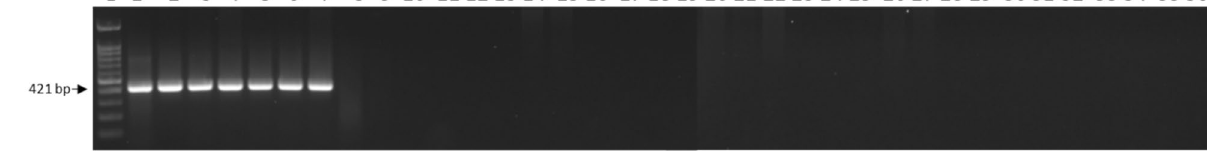
Figure 3. The specificity validation of the endpoint PCR primer pair designed to specifically detect Dickeya fangzhongdai . A total of 36 reactions including seven D. fangzhongdai: CFBP8607 T (positive control, lane 1) and PL145-PL150 (lanes 2–7) from the inclusivity panel used for the validation of the LAMP primer set. The remaining lanes consisted of reactions of gDNA templates extracted from 28 representative strains forming the PCR exclusivity panel (lanes 8–35): A6069, A5420, A6060, PL84, A5572, LMG27354, PL73, CFBP8637, LMG2414, 32F, CFBP8631, LMG17936, LMG30899, LMG30903, CFBP1357, LMG2466, LMG1268, LMG21371, LMG30744, LMG26003, 19170, A2041, A6205, A6219, A1084, A5726, A223, and DP164, and non-template control (NTC, lane panel included non-target Dickeya species, Pectobacterium , Ralstonia , Xanthomonas , and other Gram-positive bacteria, such as Clavibacter and Rathayibacter species (Fig. 3). All PCR reactions were completed by using the same gDNA sources that were used for the LAMP exclusivity assay. Reactions with D. fangzhongdai gDNA tem- plates yielded the expected amplification product, 421-bp in length, while reactions completed using template DNA from other selected species did not produce any amplification products apparent during resolution of PCR products by agarose gel electrophoresis (Fig. 3). Limit of detection and spiked assays. The limit of detection of the D. fangzhongdai LAMP assay was determined by performing the assay on a tenfold serially diluted preparation of genomic DNA of type strain CFBP8607. The LAMP assay successfully detected the target DNA at a minimum concentration of 100 fg (Fig. 4A–C). To assess possible reaction inhibition by host matrices, three spiked assays (onion, orchid, and taro) were performed by adding 5 µl crude lysate (this 5 µl amount is recommended by the manufacturer when run- ning an assay with plant samples) derived from healthy host tissues to the tenfold serially diluted genomic DNA